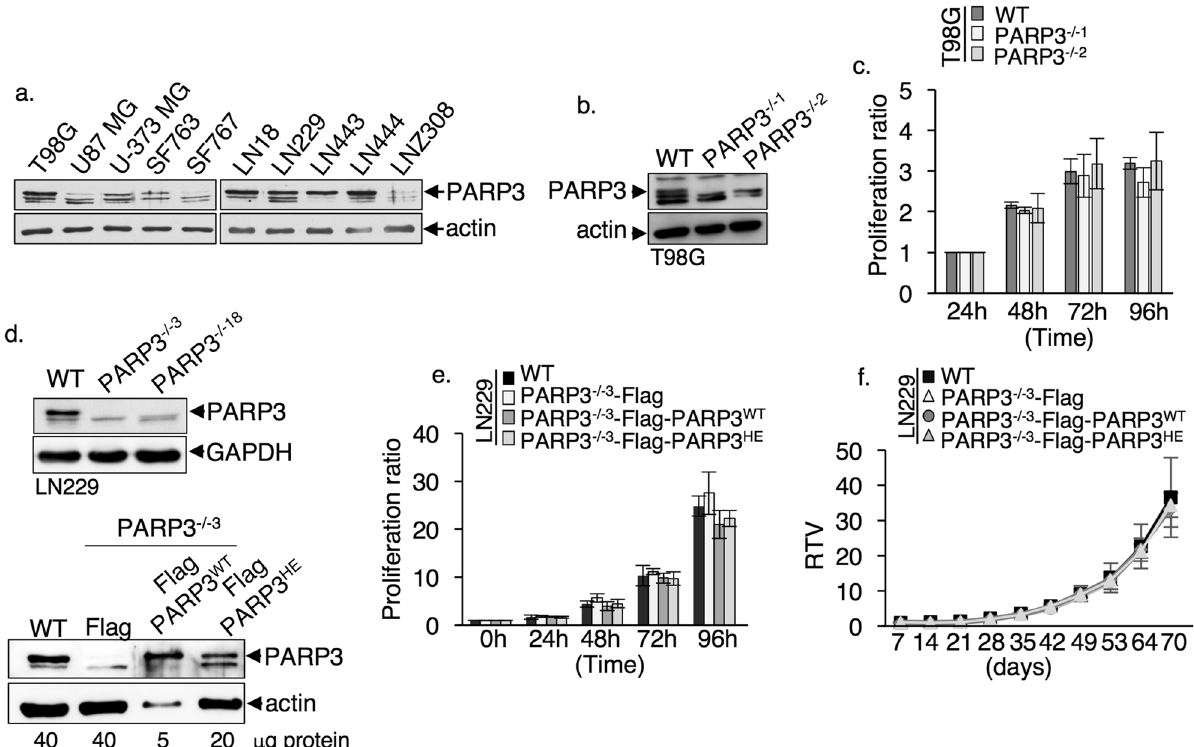
Figure 1. The absence of PARP3 has no impact on cell proliferation and tumor growth in LN229 and T98G cells. ( a ) PARP3 is highly expressed in glioblastoma cell lines. The protein expression levels of PARP3 and actin were examined on nuclear protein extracts and by western blotting using the appropriate antibodies. Original blots are shown in the supplementary information file. ( b ) Western blot analysis of PARP3 and actin expression in the wild-type (WT) and two PARP3 −/−1 , PARP3 −/−2 T98G clones selected upon screening and sequence analysis. Uncropped Western-blots are shown in the supplementary information file. ( c ) Graphs compare proliferation rates between the parental T98G (WT) and the PARP3 −/−1 and PARP3 −/−2 T98G cells. Experiments were performed three times. Mean values of triplicates ± s.d are indicated. ( d ) Upper panel , Western blot analysis of PARP3 and GAPDH expression in the wild-type (WT) and two PARP3 −/−3 , PARP3 −/−18 LN229 clones selected upon screening and sequence analysis. Lower panel, Western blot analysis of PARP3 and actin expression in the wild-type (WT) and the PARP3 −/−3 LN229 cells with a stable expression of either the Flag control (Flag), Flag- PARP3 WT or Flag-PARP3 HE . Loading amounts that have been optimized for the figure are indicated. Uncropped Western-blots are shown in the supplementary information file. ( e ) Graphs compare proliferation rates between the parental LN229 (WT) and the PARP3 −/−3 LN229 cell lines expressing either the Flag control (Flag), Flag- PARP3 WT or Flag-PARP3 HE fusion proteins. Experiments were performed three times giving similar results. Mean values of triplicates ± s.d. of a representative experiment are indicated. ( f ) Relative tumor growth curves of xenografts derived from the wild type (WT) and the PARP3 −/−3 LN229 cell lines expressing either the Flag control (Flag), Flag-PARP3 WT or Flag-PARP3 HE fusion proteins. Mean RTV ± s.d. (n = 6 individual mice) are expressed compared to tumor volumes on day 7 for all cell